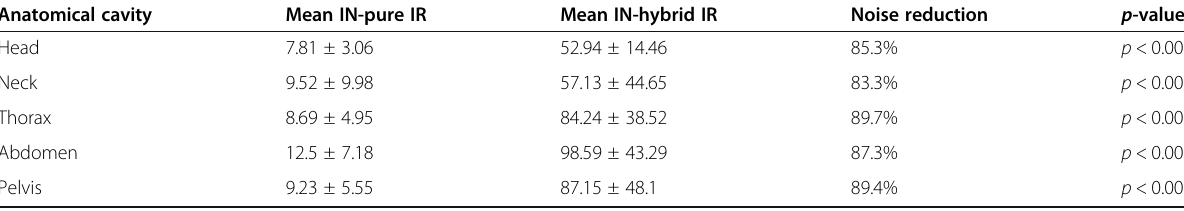
Table 2 Objective image noise: pure versus hybrid iterative reconstruction Anatomical